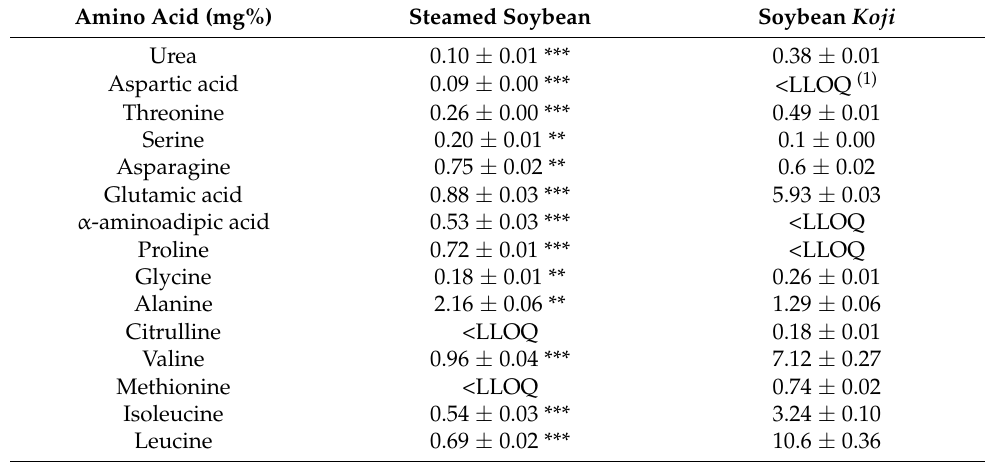
Table 4. Free amino acid composition in steamed soybean and soybean koji . Amino Acid (mg%) Steamed